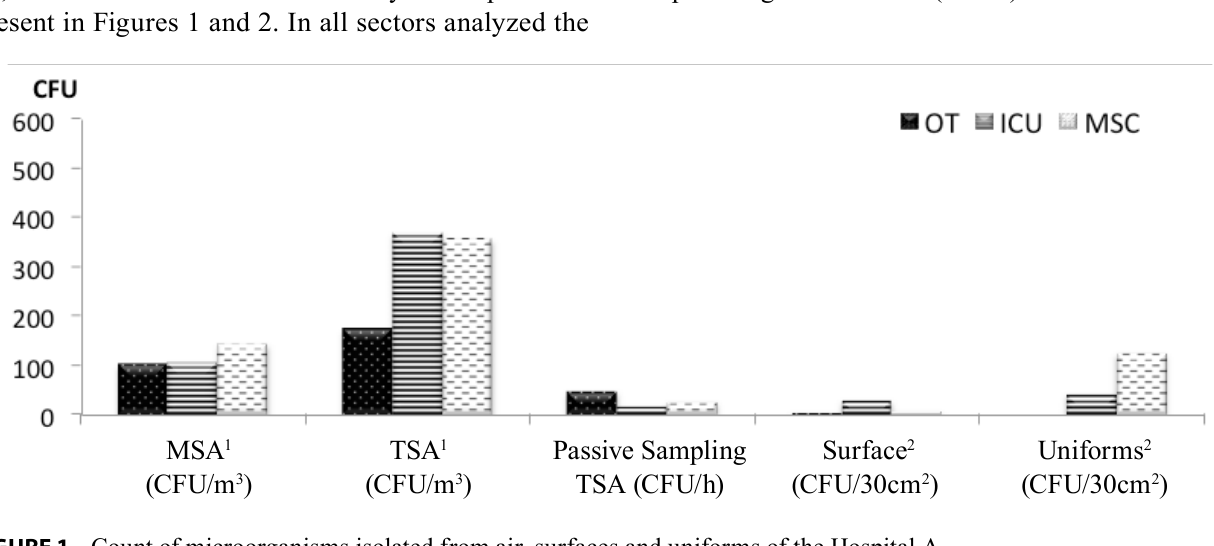
FIGURE 1 – Count of microorganisms isolated from air, surfaces and uniforms of the Hospital A. OT: operating theater; ICU: intensive care unit; MSC: material and sterilization center; MSA: mannitol salt agar; TSA: tryptic soy agar; 1: active sampling; 2: RODAC plate sampling;